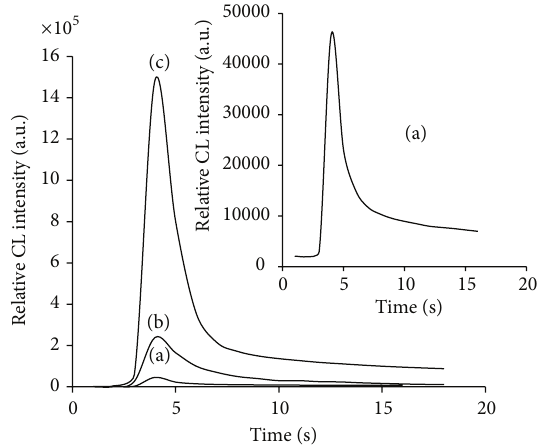
Figure 6: CL kinetic curves of ZnS QDs-H 2 O 2 system (a), 1,3- dipropylimidazolium bromide IL-ZnS QDs-H 2 O 2 system (b), and [(1,3-Pr 2 im)Br]/copper-ZnS QDs-H 2 O 2 system (c). Conditions: pH 8.0, ZnS QDs, 20 mgL −1 ; H 2 O 2 , 0.5 M.